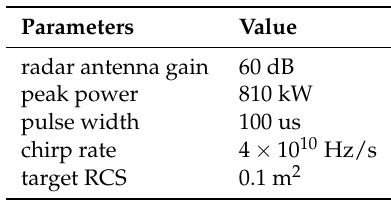
Table 1. Main parameters of radar and